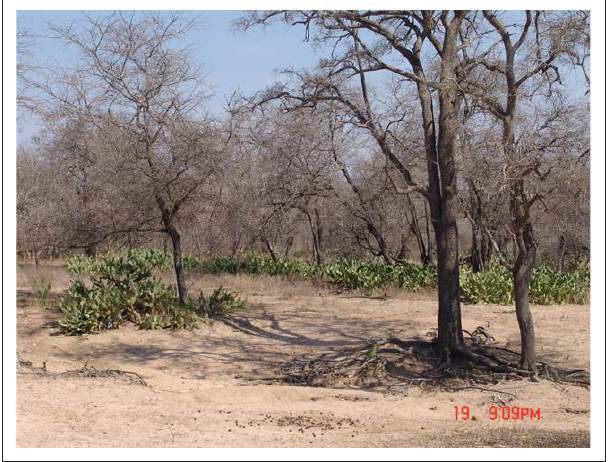
FIGURE 2: Invasion with between 11 % and 30 % cover.